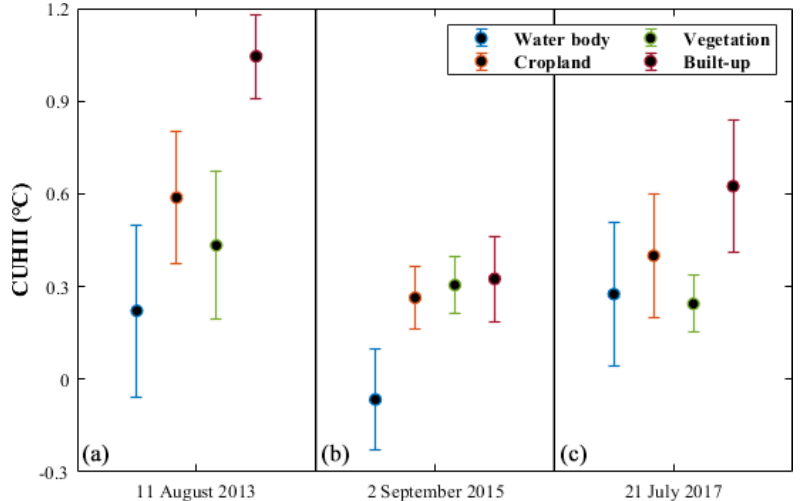
Figure 13. Mean CUHII and standard deviations over different LULC on (a) 11 August 2013, (b) 2 September 2015, and (c) 21 July 2017.